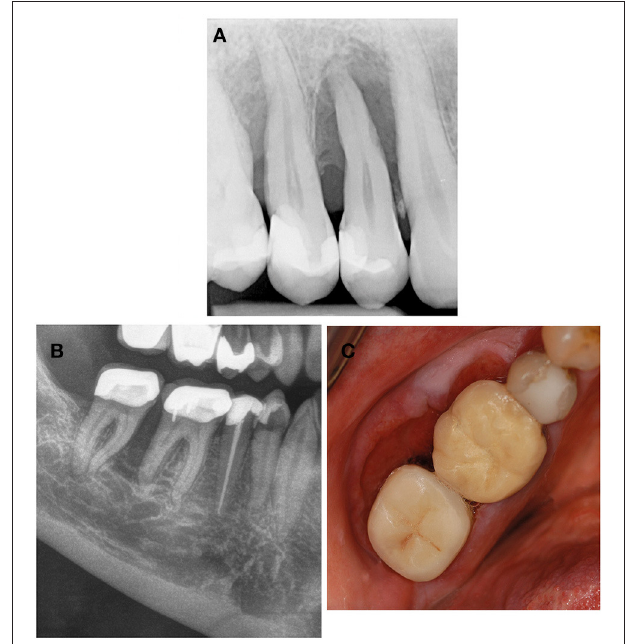
FIGURE 3 | Systemic diseases and conditions affecting the periodontal supporting tissues—neoplastic disorders. (A) Neurofibromatosis type 1 is a neurocutaneous disorder caused by mutation or deletion in the NF-1 gene and affecting the cell growth of neuronal tissues. Plexiform neurofibromas can also invade the alveolar ridge mimicking localized periodontitis. (B,C) Squamous cell carcinoma invading the alveolar bone is a differential diagnosis to benign neoplastic disorders but also to localized